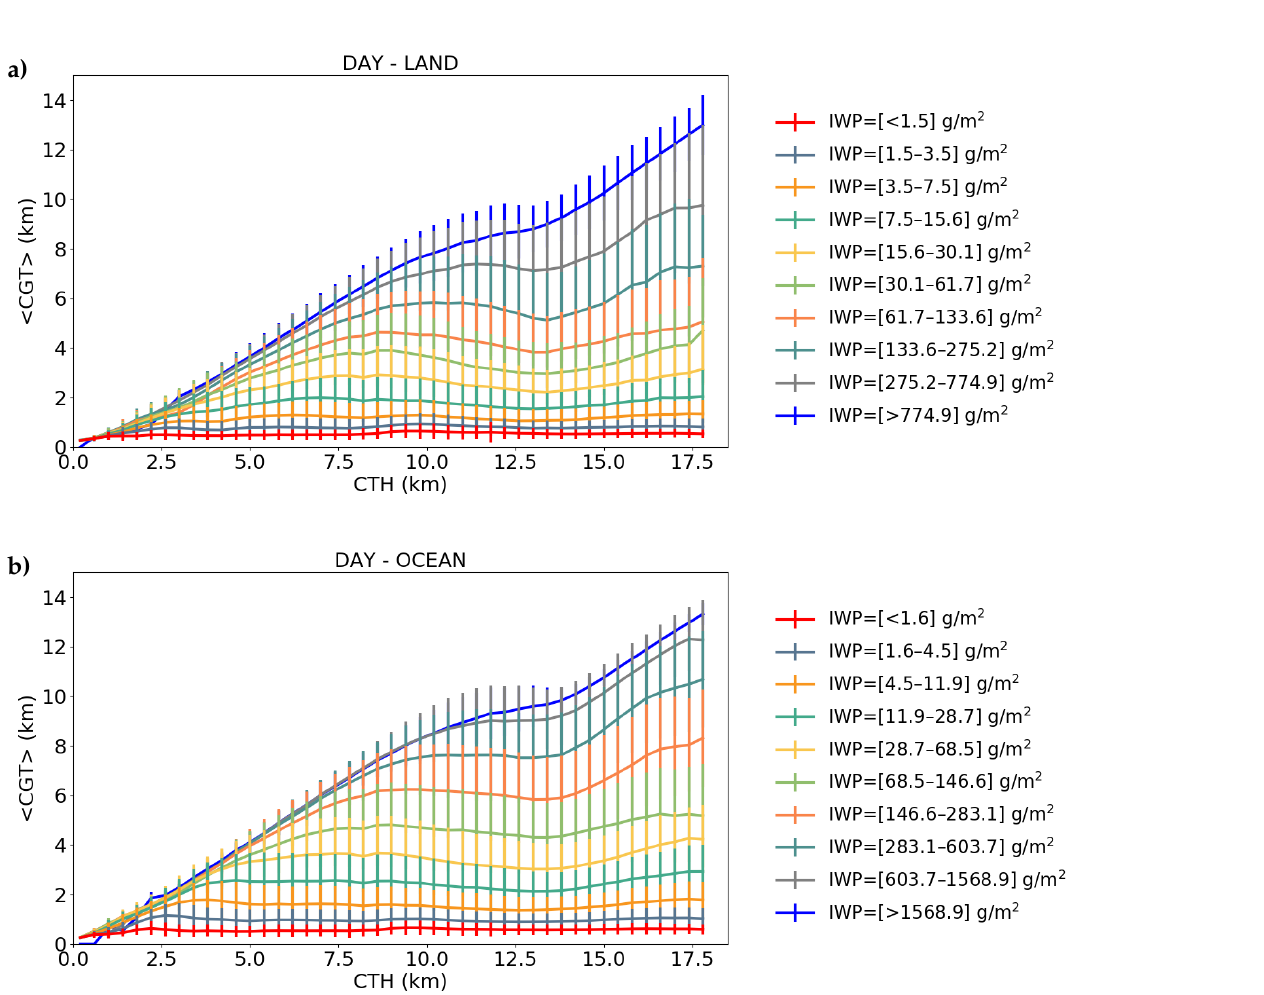
Figure 6. Mean CGT (solid line) and its standard deviation (vertical bars) obtained over 6 years of the level 2 products provided by the DARDAR (lidar radar) algorithm [3,76] for different classes of CTH (abscissa) and IWP (colored line) over land ( a ) and ocean ( b ) during